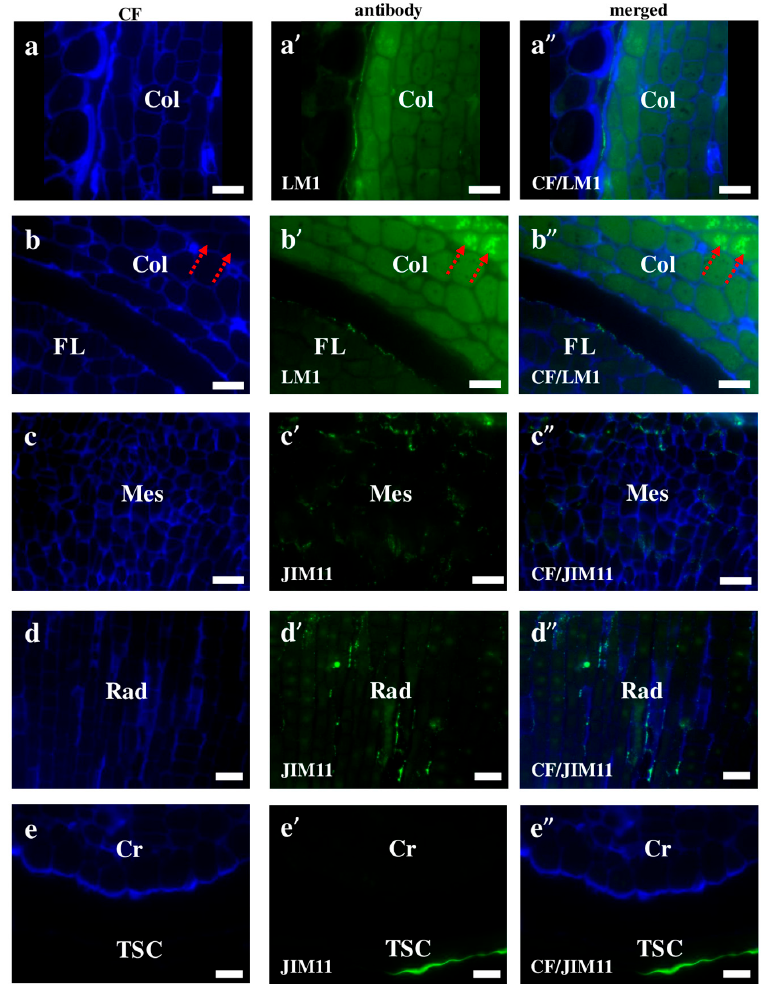
Figure 5. Immunolocalisation of extensins in Brachypodium embryos. Both ( a – a” ) coleoptile and ( b – b” ) coleoptile with first leaf with LM1; ( c – c” , d – d” , e – e” ) mesocotyl, radicula and coleorhiza (including the seed coat) with JIM11, respectively. Arrows show outer layers of coleoptile including protodermal cells ( b – b” ). Abbreviations: CF—calcofluor, Col—coleoptile, Cr—coleorhiza, FL—first leaf, Mes—mesocotyl, Rad—radicula, and TSC—the seed coat. Bars: 10 µm.